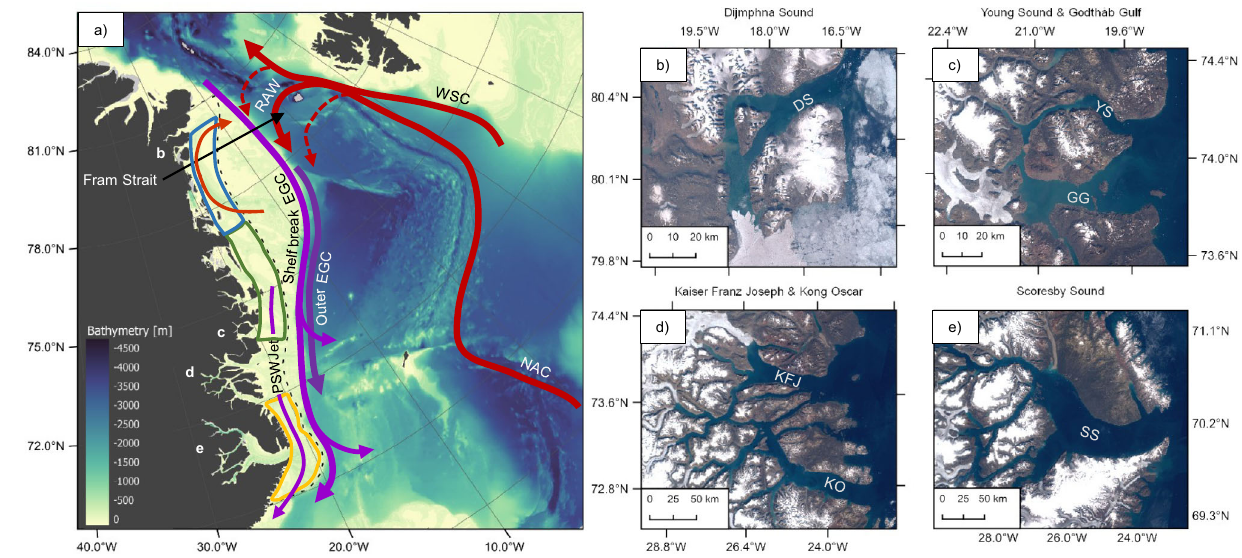
Fig.1|SchematicofsurfacecirculationinNortheastGreenland(NEG). Themain circulationfeaturesandwatermassesthatin fl uencetheNEGshelfandfjords( a )are the East Greenland Current system (EGC) comprising of the Shelf break EGC, the Outer EGC and the Polar Surface Water Jet (PSW Jet) shown in purple, and the Norwegian Atlantic Current (NAC), the West Spitsbergen Current (WSC), and Recirculating Atlantic Water (RAW), shown in red. Currents are based on Håvik etal. 11 andaugmentedwithnear-surfaceshelfcirculation(redcurrentcurvingnorth andeastontheshelf)fromBourkeetal. 68 .Backgroundshowsbathymetryfromthe